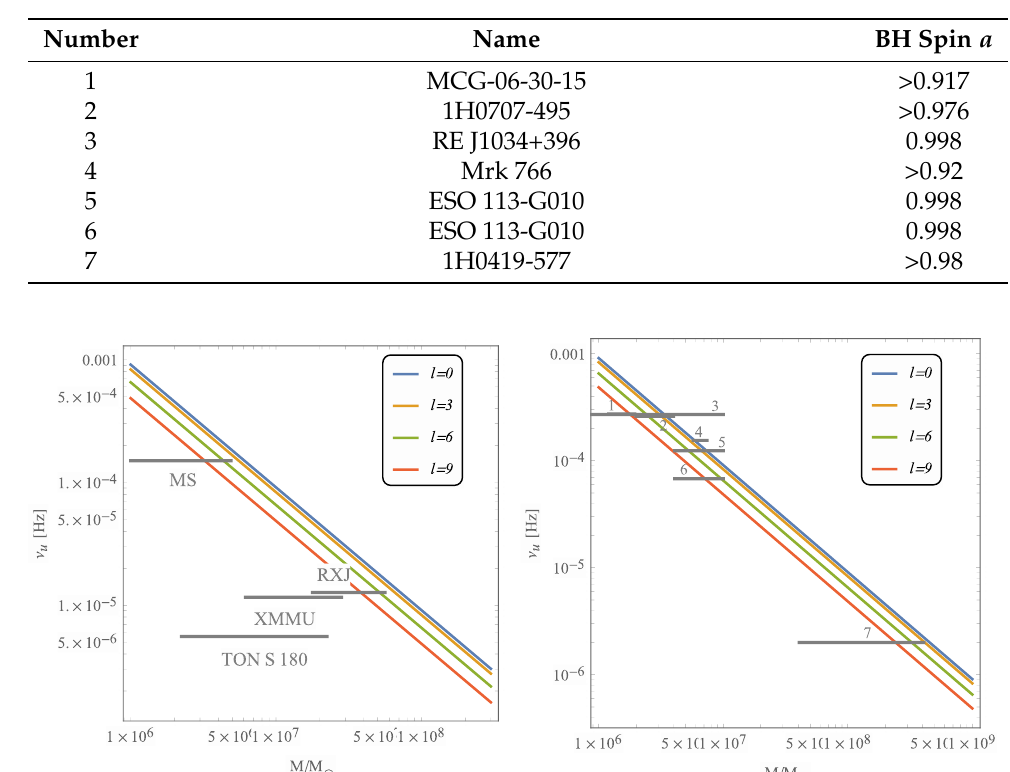
Figure 9. Fit of 3:2 frequencies ratio to mass estimate of assumed supermassive black holes in active galactic nuclei for various values of the parameter l giving regular black holes. The sources with unknown rotation estimates are marked on the left panel. On the right panel are sources with known estimate of spin listed in Table 1 (cf. [34]). Notice that the curves almost coincide. Table 1. Table of names of supermassive quasars with estimated spin presented in the right panels of Figures 9–11 [34].